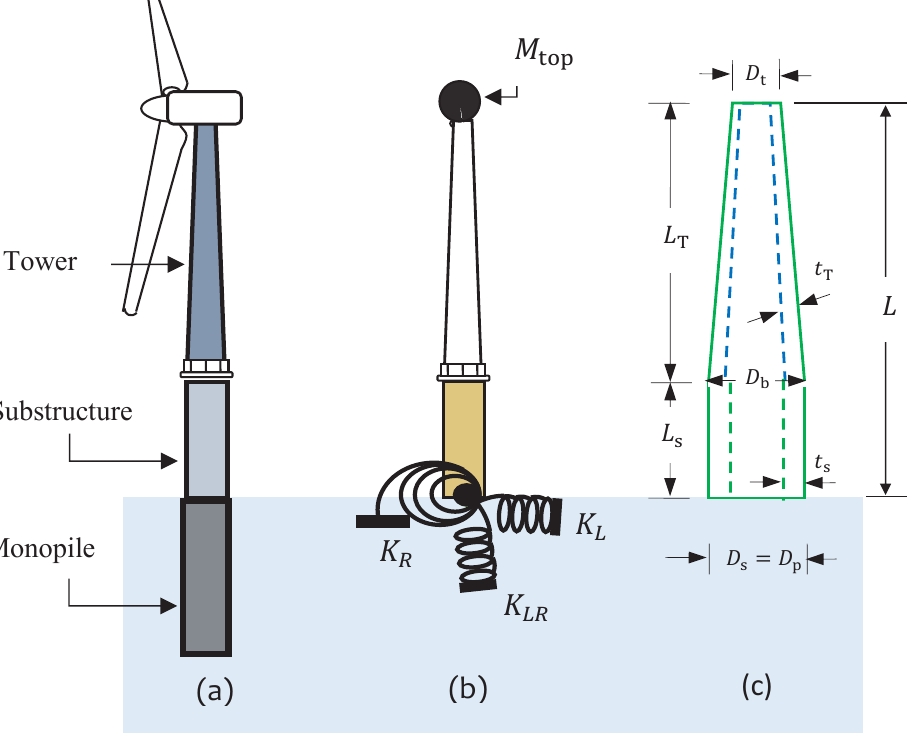
Figure 9: (a) (Substructure/tower/monopile) system, (b) Tower modeling with three springs representing the soil–monopile interaction, (c) Details of substructure and tower.